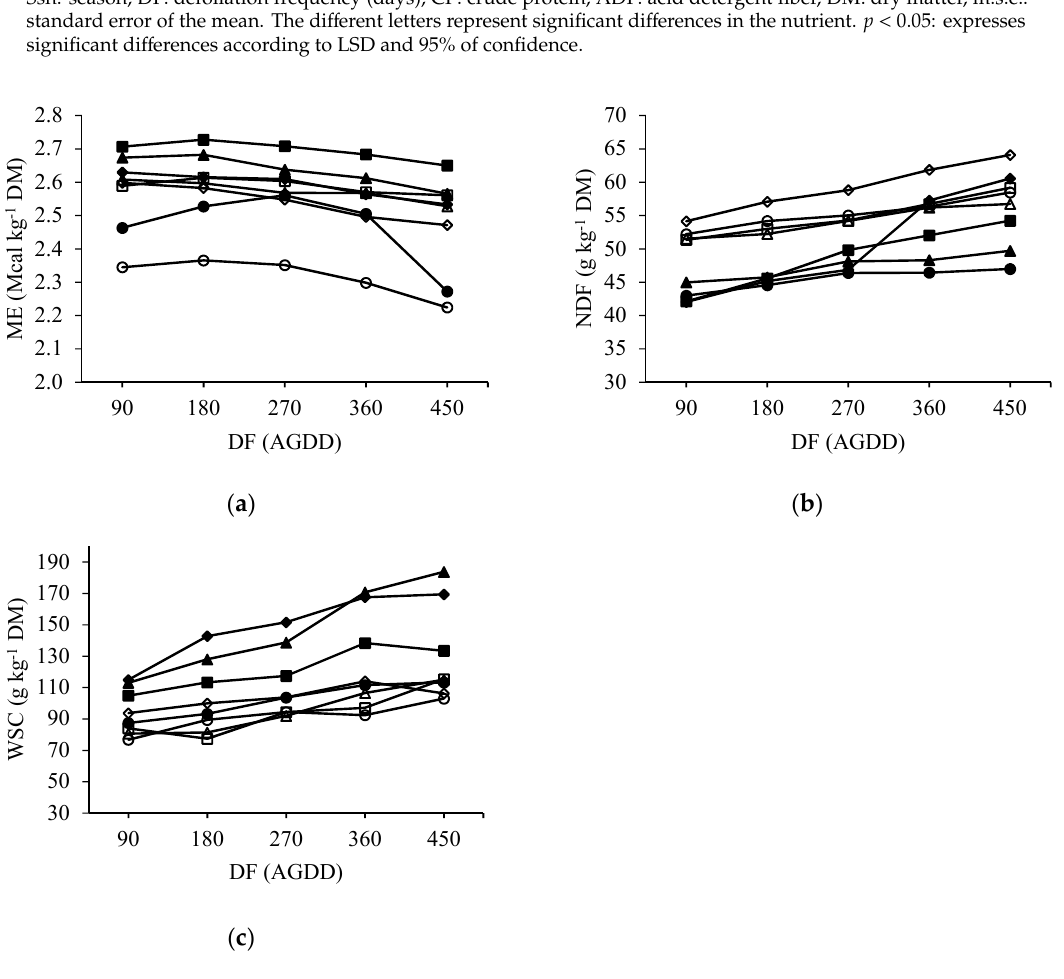
Figure 3. Interaction between defoliation frequency (DF) measured as accumulated growing degree-days (AGDD), species and season for: ( a ) metabolizable energy (ME), ( b ) neutral detergent fiber (NDF), and ( c ) water-soluble carbohydrates (WSC). Lolium perenne in summer ( ● ), Bromus valdivianus in summer ( ○ ), L. perenne in autumn ( ■ ), B. valdivianus in autumn ( □ ), L. perenne in winter ( ▲ ), B. valdivianus in winter ( △ ), L. perenne in spring ( ♦ ) and B. valdivianus in spring ( ◊ ).